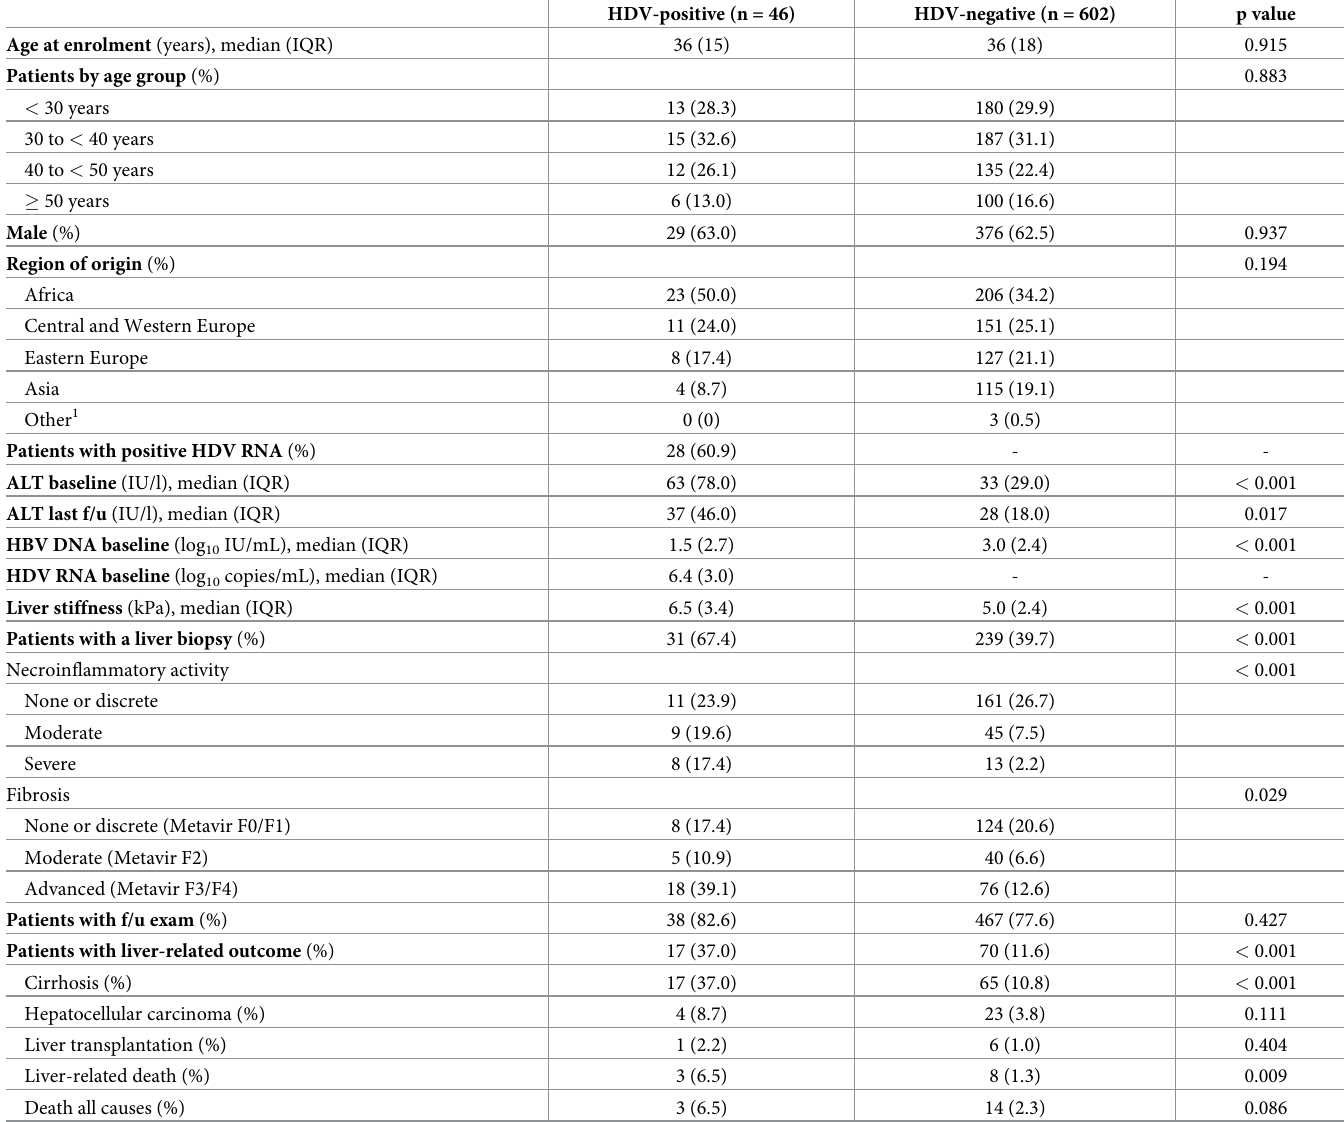
Table 2. Characteristics of patients by HDV